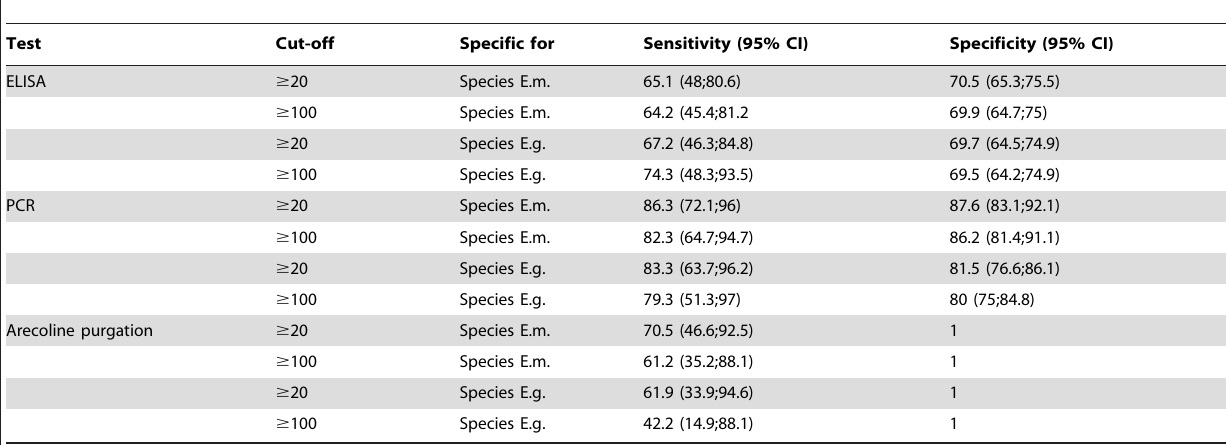
Table 2. Estimated test accuracies with different cut-offs of the arecoline purgation.